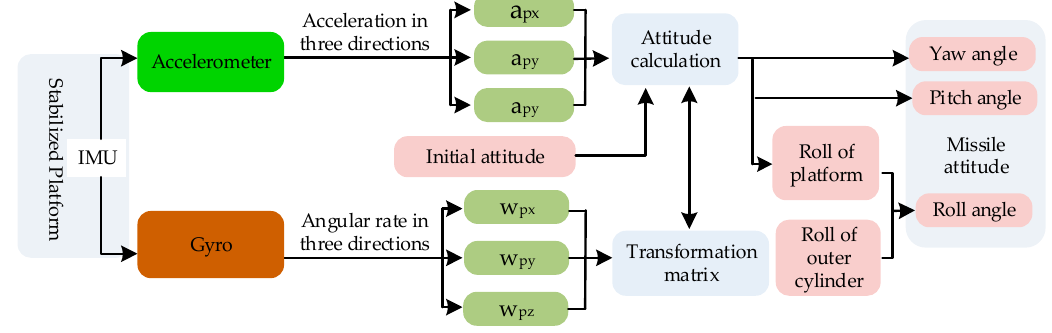
Figure 1. Block diagram of the overall scheme of the SMNS.